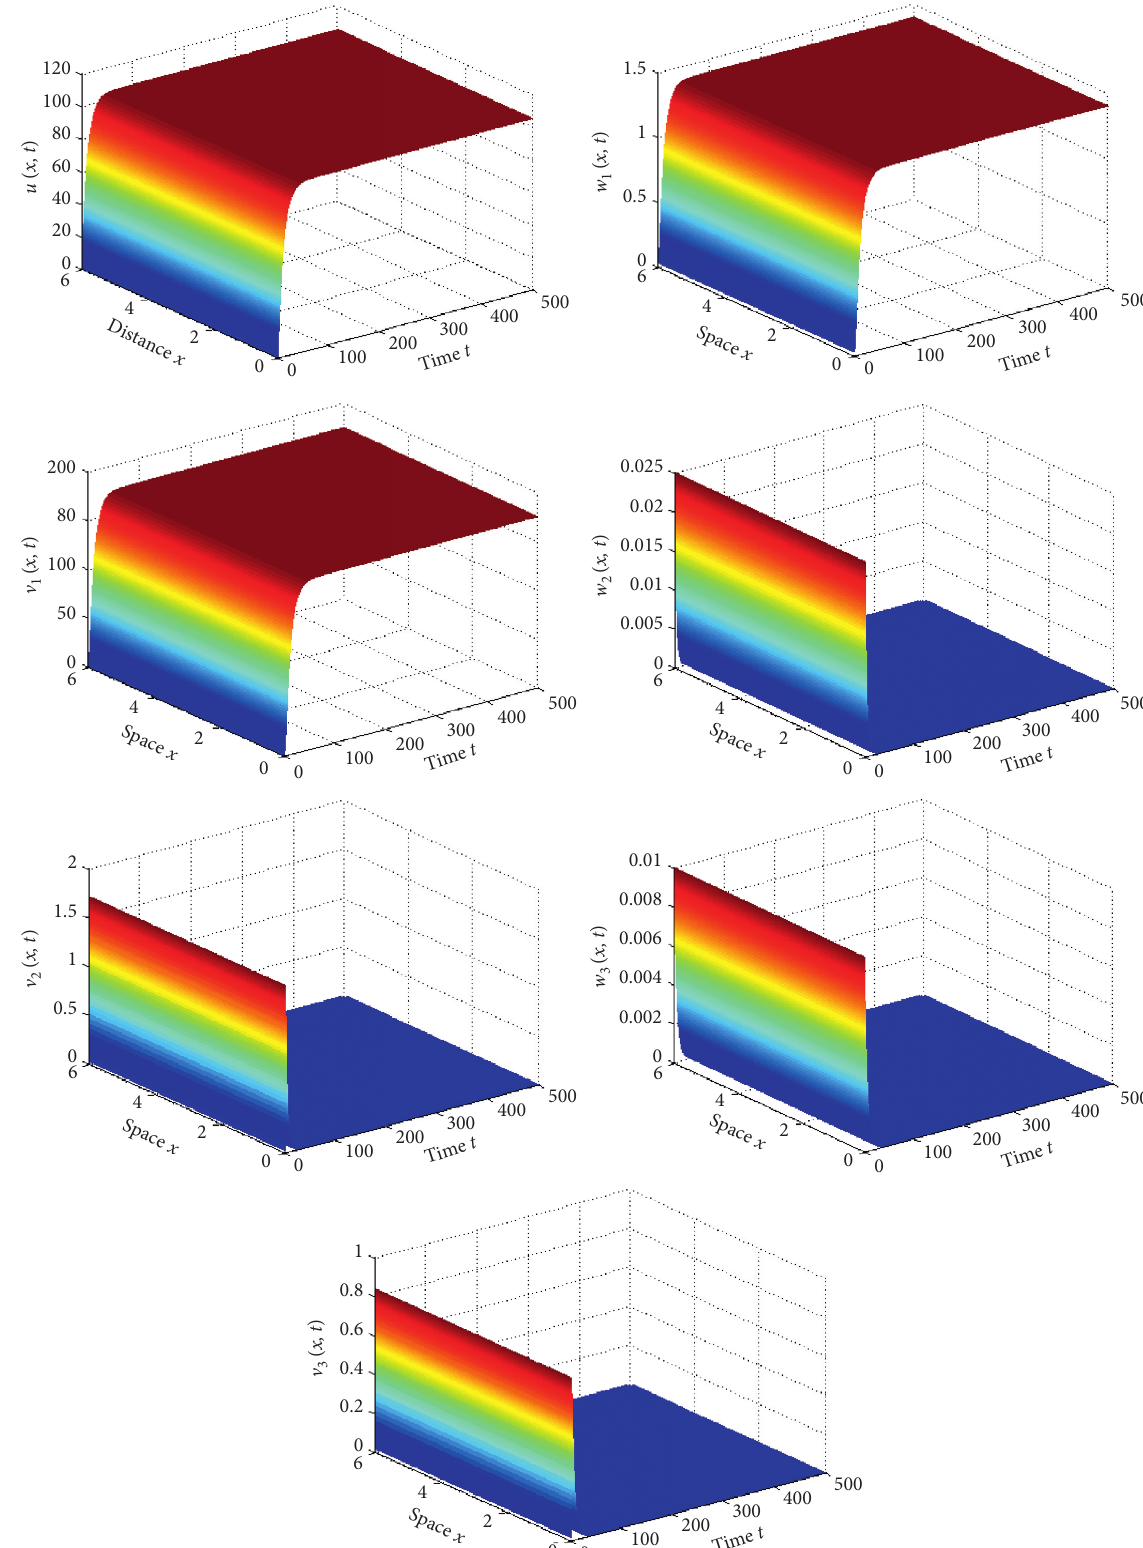
Figure 3: Taking m � 0 . 0015, δ 1; β 2